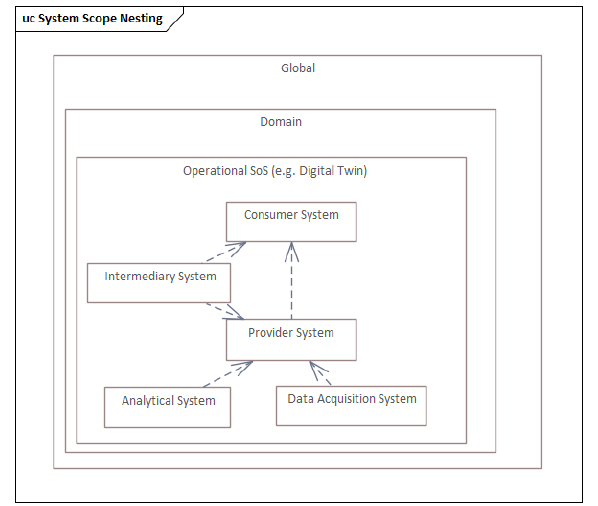
Figure 6. Scope Characterisation for Systems of Systems